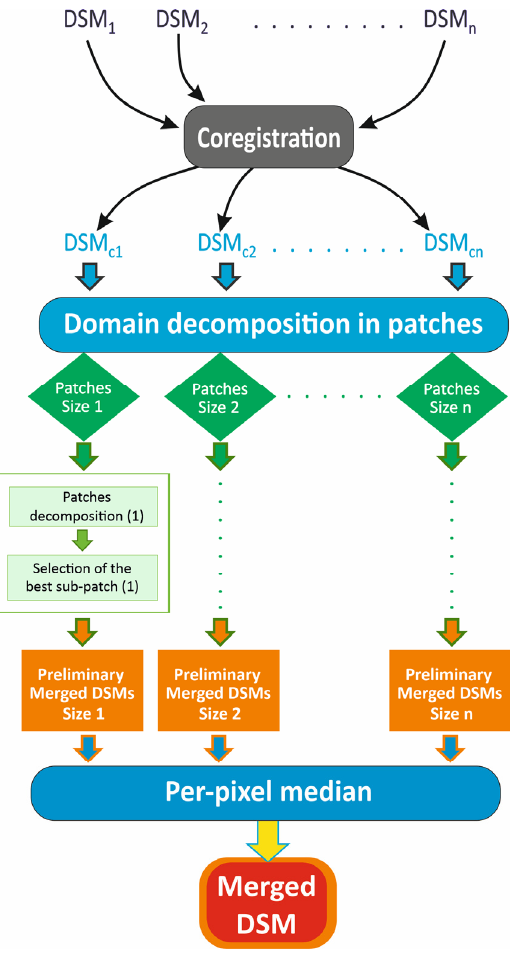
Figure 1. Scheme of the algorithm developed for Digital Surface Models (DSM) fusion. See text for